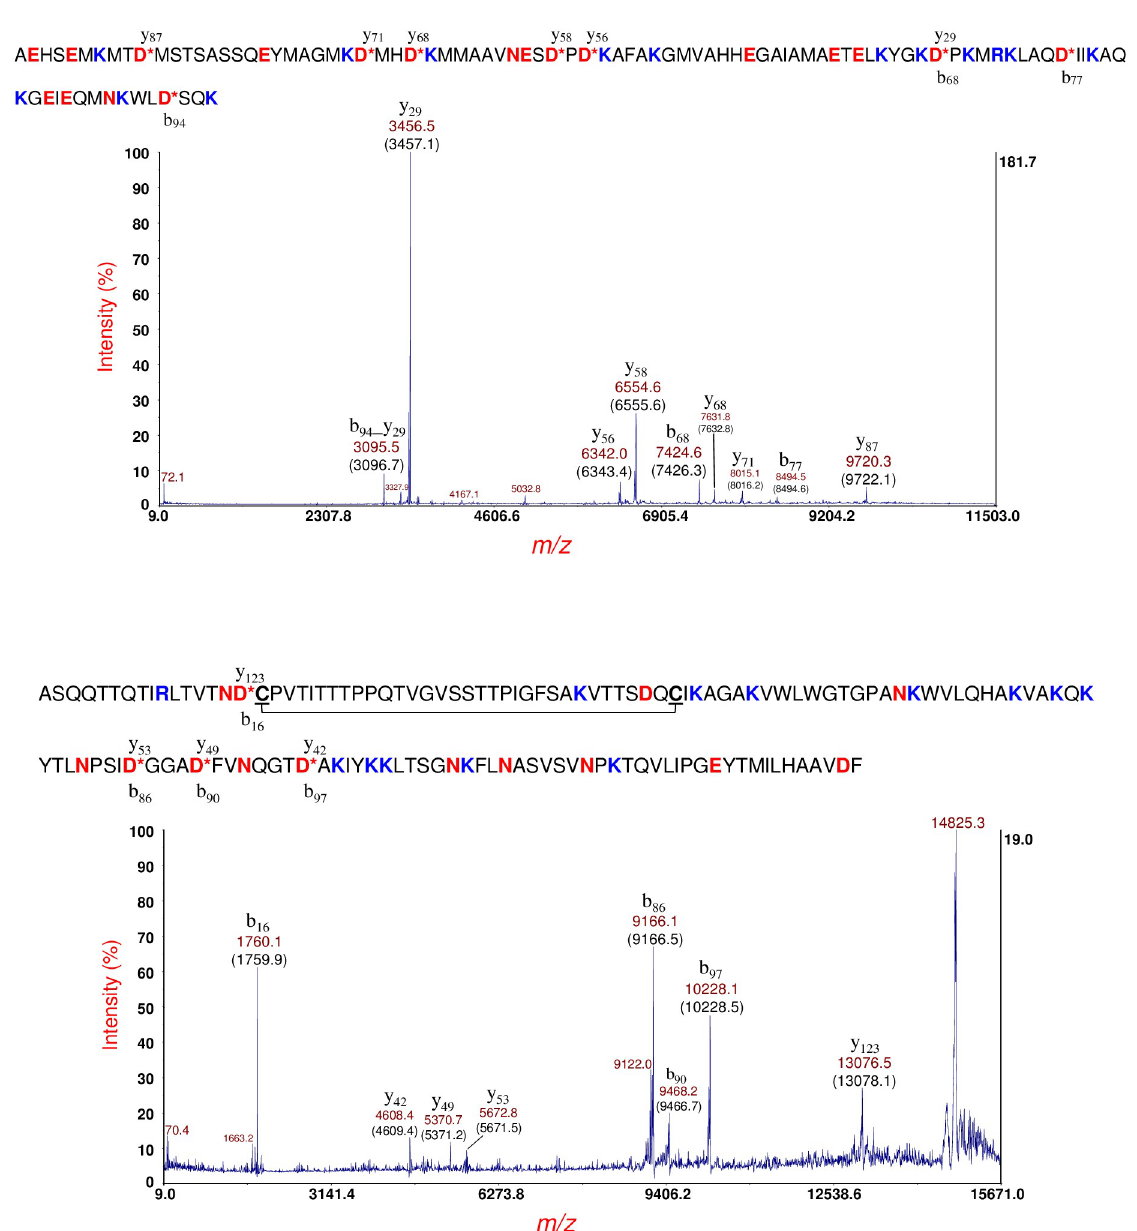
Fig 10. Top panel: MS/MS of the protein ion at m/z 10892 [M+H] + shown in Fig 8 (bottom panel). A hypothetical protein (EGT69515.1, C22711_3545) sequence (shown above) was identified. Bottom panel: MS/MS of a protein ion detected at m/z 14839 [M+H] + of this strain cultured overnight on LBA supplemented with 60 ng/mL ciprofloxacin. [27] This protein ion also appears at m/z 14852 [M+H] + in Fig 8 (bottom panel). The protein was identified as a hypothetical protein (shown above) whose gene is encoded by a plasmid: O3K_26197 (AFS77026.1). A 28-residue N-terminal signal peptide has been removed and there are two cysteine residues: C17 and C49 (underlined), that form an intramolecular disulfide bond (symbolized by a connecting